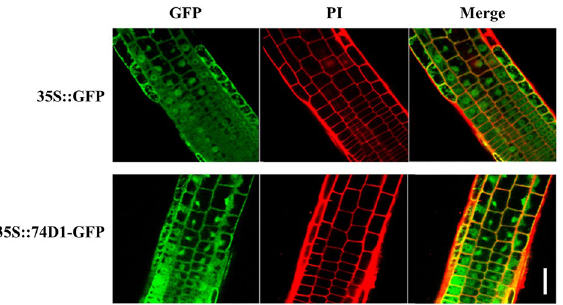
Figure 4. The subcellular localization of UGT74D1 protein. 35S::GFP construct was used as the control in this study. 35S::UGT74D1-GFP construct was used to produce the fusion protein of UGT74D1-GFP. PI: Propidium Iodide staining. Scale bar = 10 μm.